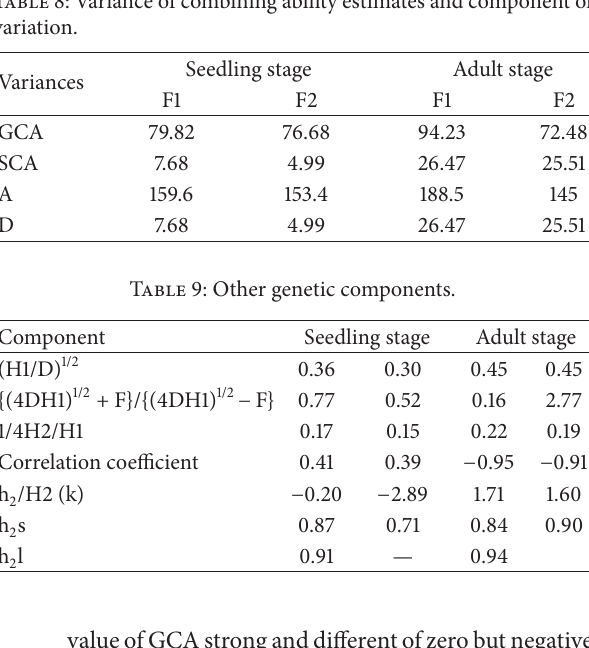
value of GCA strong and different of zero but negative and varies from 8.99 to 12.44 for F1 and 7.51 to